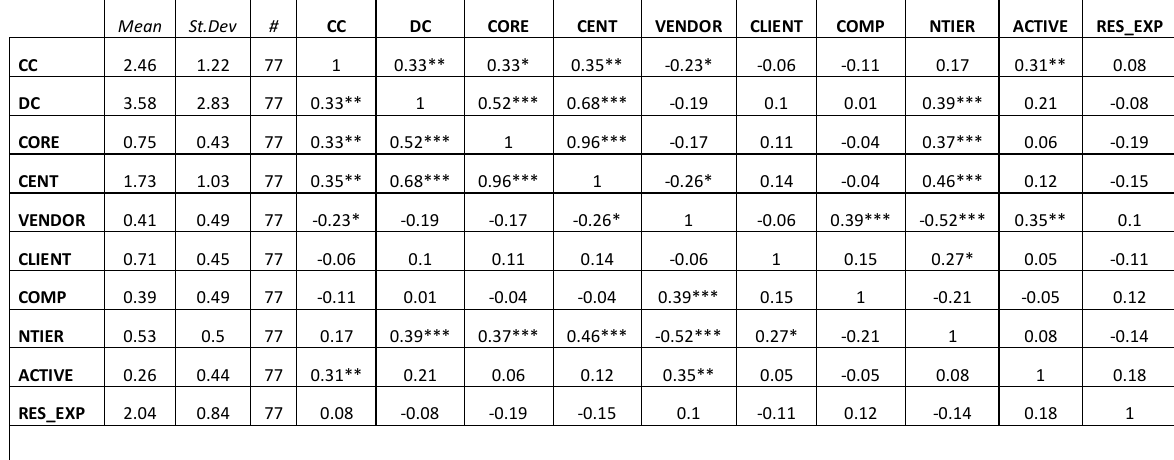
Table 2. Descriptive Statistics and Correlation